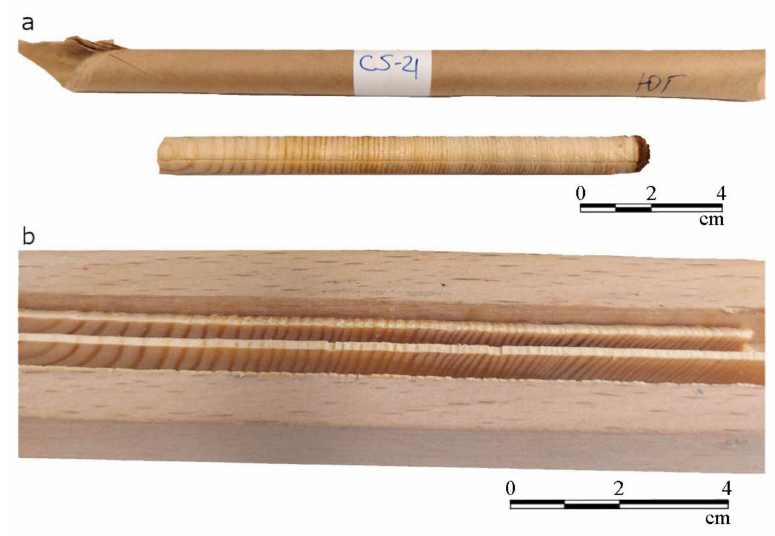
Figure 1. The cores after extraction are wrapped in a piece of firm paper and marked ( a ). A view of a core in a wooden holder after sawing has been performed ( b ). The wooden slice is ready for extraction.